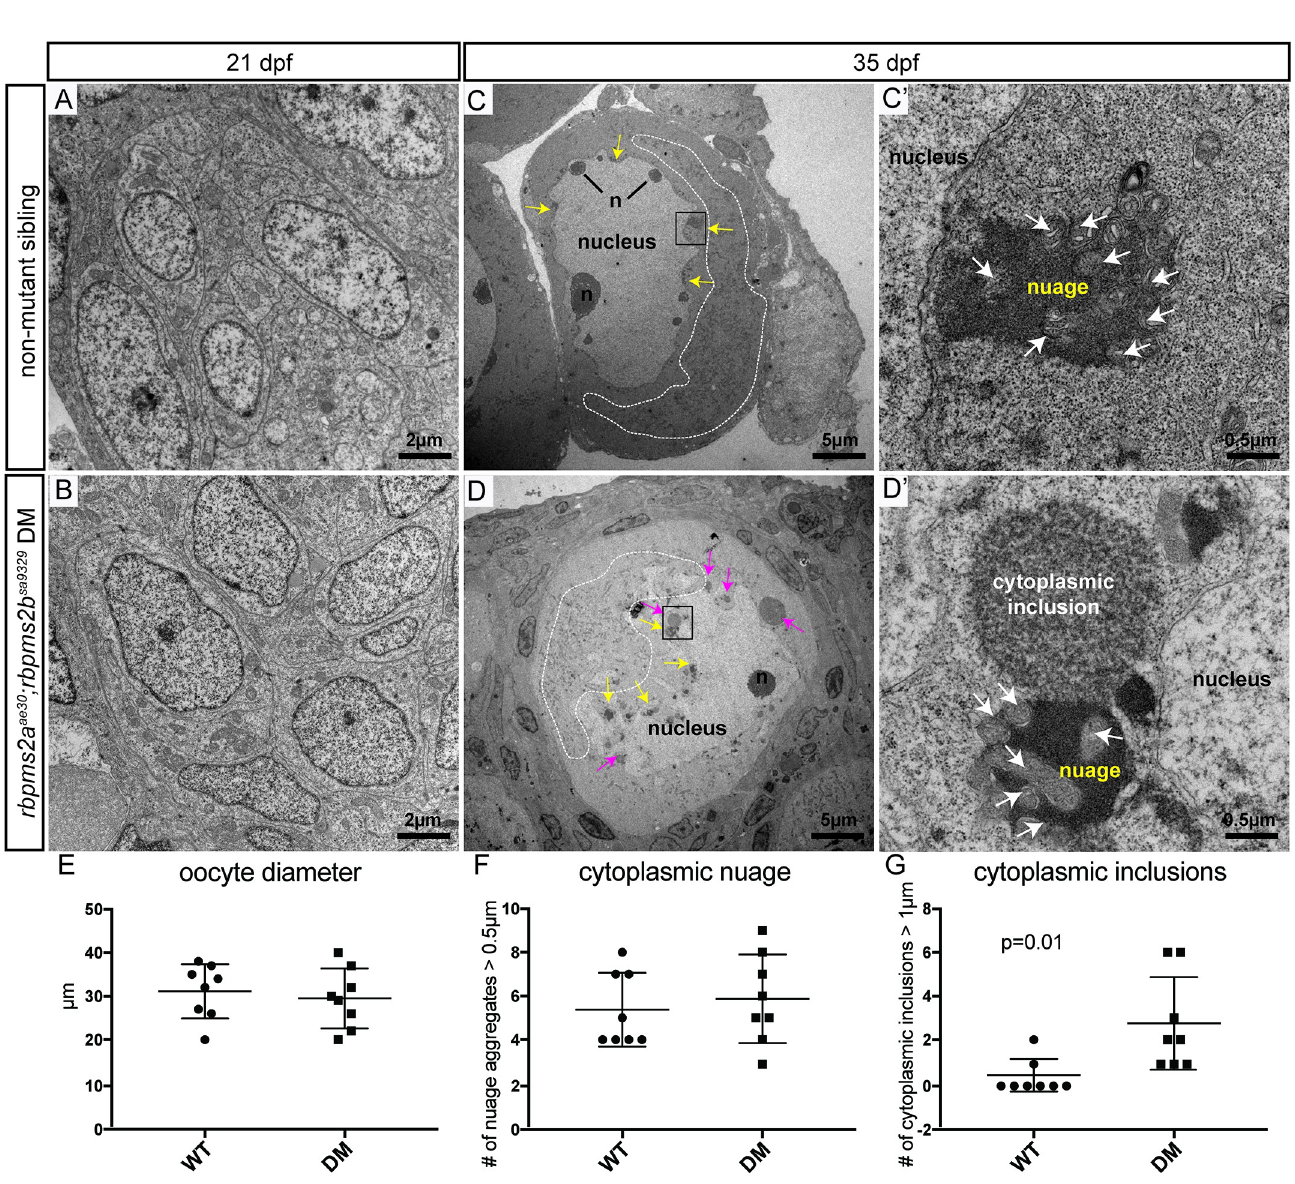
Fig 9. rbpms2 mutant oocytes contain atypical cytoplasmic inclusions. (A-B) Comparable clusters of gonocytes from d21 non-mutant siblings (A), and rbpms2 double mutants (B). (C,D) Oocytes from d35 non-mutant siblings (C), and rbpms2 double mutants (D). Marked features include: n = nucleoli, white dotted line outlining areas of mitochondrial enrichment, yellow arrows indicating nuage accumulations, pink arrows indicating atypical cytoplasmic inclusions. Areas marked in a black box in (C, D) are magnified in (C’,D’). (C’, D’) High magnification images of nuage with associated mitochondria (white arrows) in non-mutant oocyte (C’), and juxtaposed nuage and atypical cytoplasmic inclusion in rbpms2 mutant oocyte (D’). (E-G) Oocytes of comparable diameter (E) were used to quantify and compare number of nuage aggregates over 0.5 μ m (F), and number of cytoplasmic inclusions figover 1 μ m (G). Significance was analyzed with unpaired